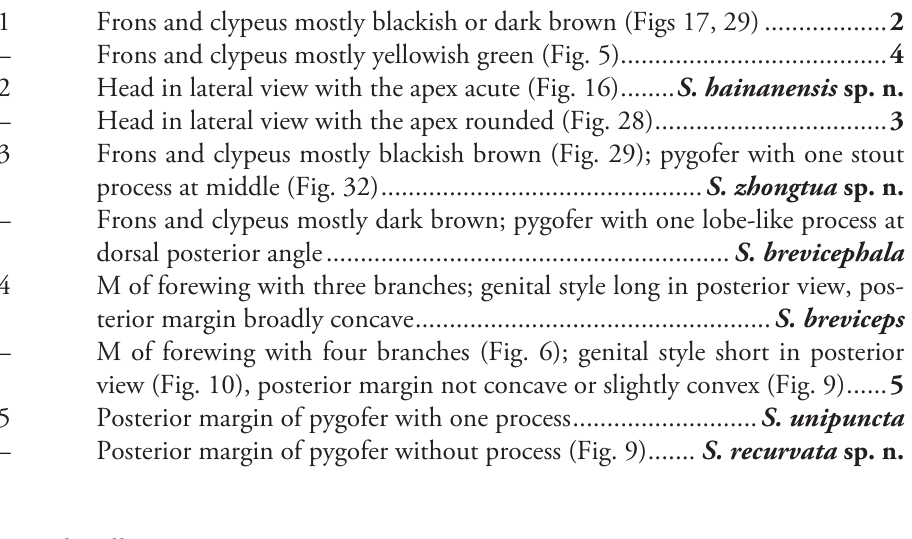
Measurements. Body length including forewing: male 5.78–5.98 mm (N = 6), fe- male 6.15–6.25 mm (N = 12); forewing length: male 4.90–5.15 mm (N = 6), female 5.30–5.40 mm (N = 12). Coloration. General color light yellowish brown with somewhat green. Ocelli reddish brown, eyes black brown. Antennae with one black spot at apex of